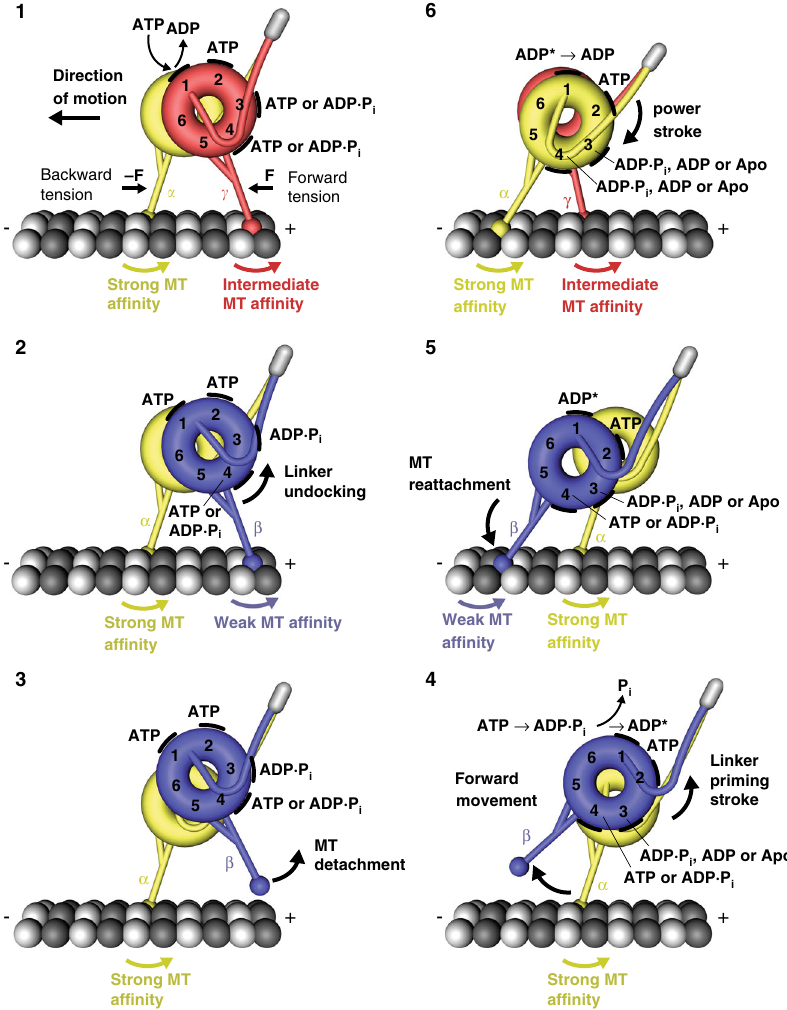
Fig. 7 Model for the mechanochemical cycle of dynein. Following ADP release from AAA1, ATP binding (step 1) causes the undocking of the linker from AAA5 and the subsequent transition from the γ registry of the stalk helices with intermediate weak MT-af fi nity (red) to the weakly MT-binding β registry (blue) only if AAA4 is bound to ATP or in the post-hydrolysis state (step 2). After the detachment of the rear head (step 3), which occurs when AAA3 is in the ADP ∙ Pi transition state or bound to ADP, the ‘ recocking ’ of the linker (priming stroke) displaces the detached head forward to a new front MT-binding site while the MT-attached head bears the load (step 4). Following ATP hydrolysis and Pi release from AAA1 (step 4), rebinding to the MT in the weakly MT-binding β registry (step 5) causes the transition from the ‘ high-energy ADP* state ’ to the ‘ low-energy ADP state ’ , which generates a linker swing (powerstroke), resulting in the docking of the linker to AAA5 and the transition into the strong MT-binding α registry (yellow) of the stalk helices (step 6). A prerequisite for the strong binding state is that AAA3 is not bound to ADP, suggesting that AAA3 is still in the ADP ∙ Pi state or nucleotide free. The MT minus-end-directed linker swing generates the forward movement of dynein ’ s center of mass and the attached